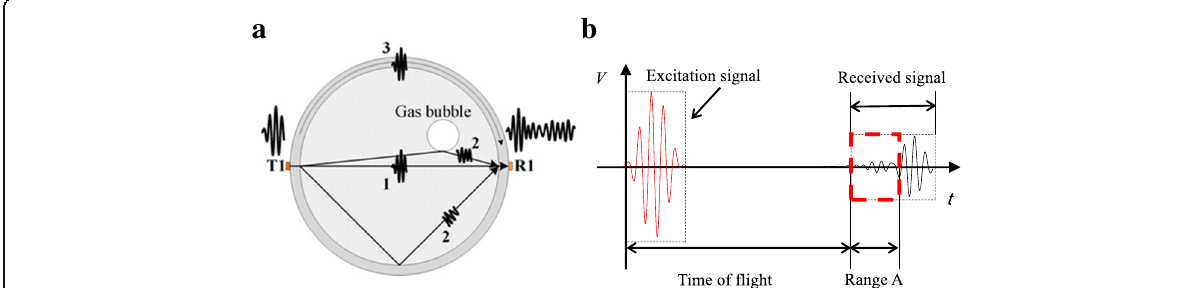
Fig. 2 a The three kinds of paths for ultrasonic wave propagation excitation signal and received signal (note: 1 refers to direct wave signal, 2 is reflected signal from bubble and pipe wall, and 3 is the signal propagated through the pipe wall). b Measurement principle of ultrasonic transmission mode